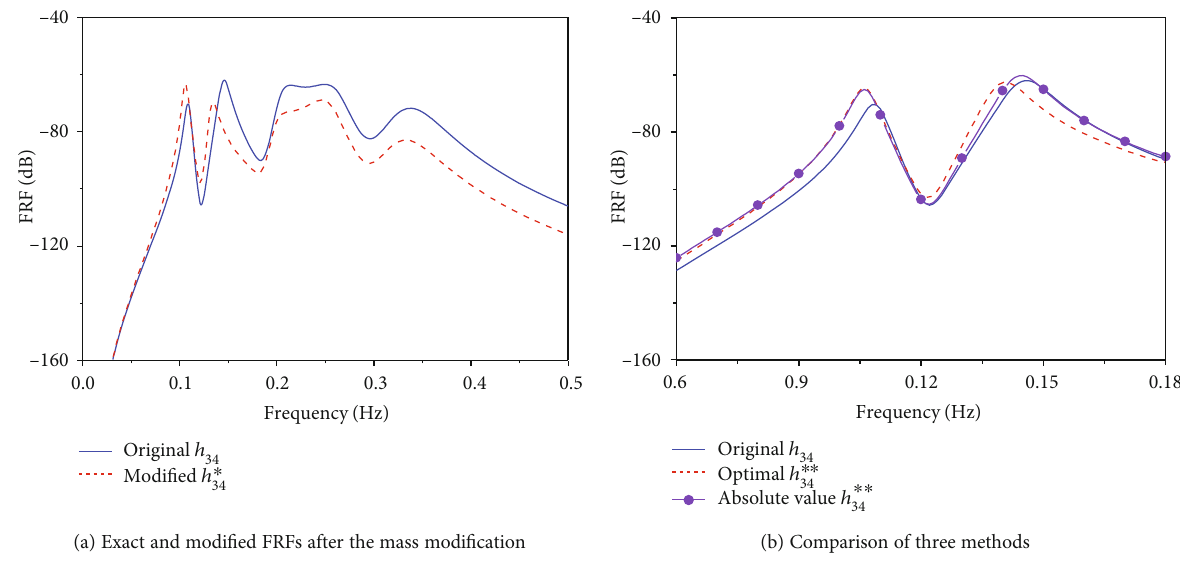
Figure 12: Comparison of FRFs between original and modi fi ed systems with modal damping ratio 4.24%.